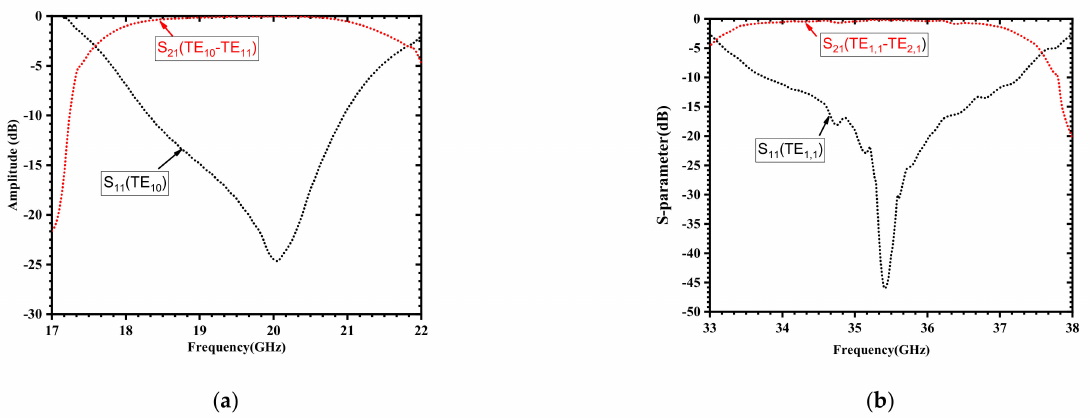
Figure 11. The electric field diagram of input coupler, ( a ) the output mode is TE mode is TE . (cid:35) 1,1